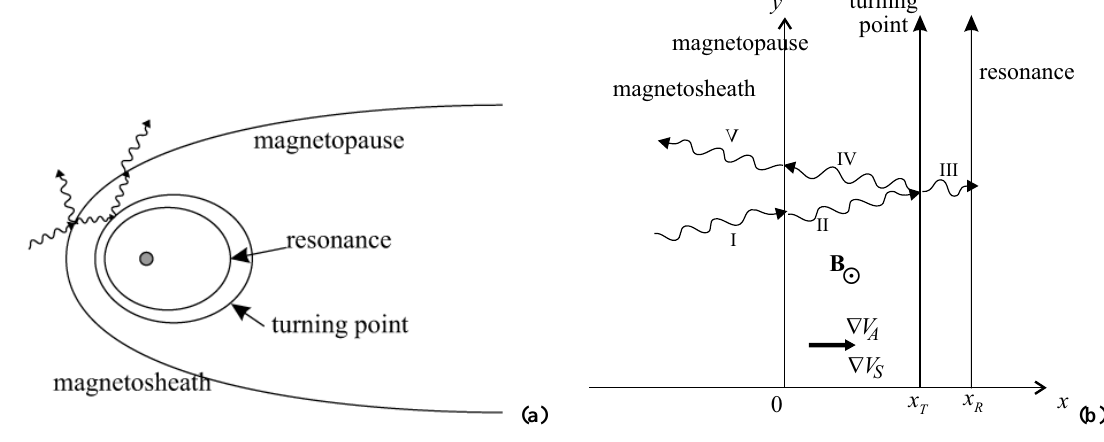
Fig. 1. Box model of the magnetospheric waveguide or cavity. (a) Equatorial plane of magnetosphere (b) Mapping to a box model (see text for